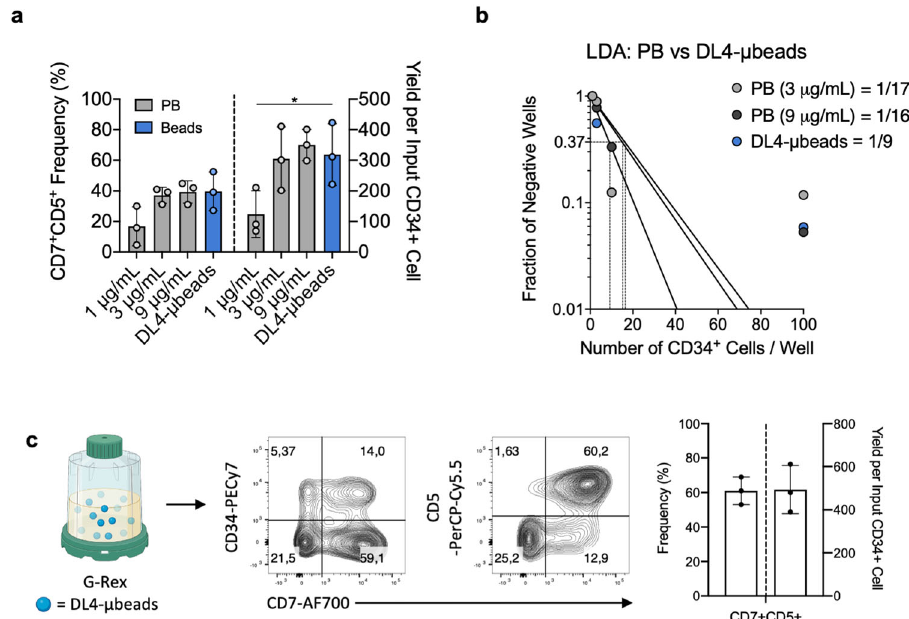
Fig. 1 DL4- μ beads activate Notch signaling and initiate the T cell program in HSPCs. a Depiction of DL4-Fc fusion construct showing its components of the extracellular domain of human DL4, the Fc region of human IgG3 (IgG3Fc) and a BirA recognition sequence (AviTag) at its C-terminus. b Quanti fi cation of saturation of beads by DL4-Fc. DL4- µ beads were prepared by conjugating increasing amounts of DL4-Fc (0.01 μ g to 1 μ g) to 2 × 10 5 SA-coated μ beads and stained with anti-human IgG-APCCy7. c Evaluation of the effect of bead size on Notch activation. 3 ×104 3T3-N1Cluc cells were incubated on plates pretreated with hIgG as negative control or with DL4-Fc at 10 μ g/mL. The number of beads in each condition presented in aggregate, the same surface area and therefore, the same total number of DL4-Fc molecules. 24 h after plating, the cells were lysed and analyzed for luciferase activity ( n = 3). d , Analysis of the ability of DL4- µ beads to support T cell development. Mouse fetal liver derived HSPCs were incubated for 7 days with unconjugated µ beads or DL4- µ beads in serum-free media containing SCF, IL-7 and Flt3-L. Co-cultures were harvested and analyzed for the presence of CD25, CD90, CD19 and CD11b using fl ow cytometry. e D28 cultures of DL4- µ beads and mouse LSKs were analyzed for the presence of late T cell markers (CD4, CD8, CD3 and TCR αβ ). f Representative fl ow cytometry plots of human cord blood-derived CD34 + cells cultured for 7 and 14 days with DL4- µ beads in serum- free media supplemented with SCF, IL-7 and Flt3-L. Cells were harvested and analyzed for the surface expression of CD34, CD5, and CD7 using fl ow cytometry. g Frequencies of the indicated proT-cell phenotypes after 7 days or 14 days, for the markers shown in (f) as well CD33 and CD56 (not shown) ( n = 6). h Total cell expansion on D14, normalized to input day 0 CD34 + CB-derived CD34 + after culture with DL4- µ beads ( n = 6). i MACS-enriched CB- and mPB-CD34 + cells were placed in limited numbers in wells of a 96-well plate containing DL4- µ beads and cultured for 14 days before harvesting for fl ow cytometry. Individual wells were scored for the presence of T cell progenitors based on CD45 + CD7 + CD56 − . Statistical analysis was performed via the method of maximum likelihood applied to the Poisson model, and shown in Supplementary Table 1. Data represent means ± s.d. of n independent